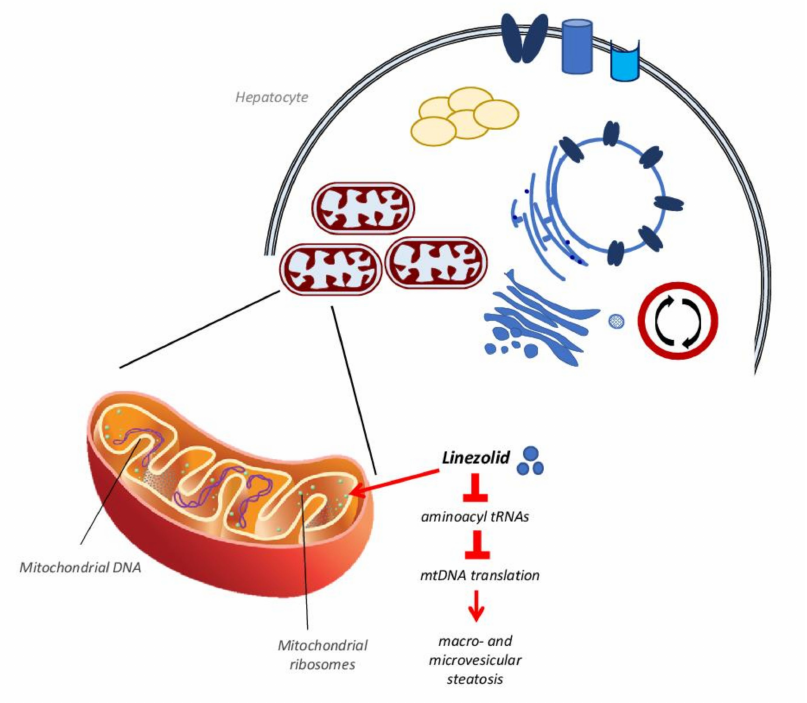
Figure 3. Linezolid activity on mitochondrial ribosomes. Linezolid stops the protein synthesis in bacteria by binding their ribosomes. At the same time, this drug can bind human mitochondrial ribosomes inhibiting the bond of aminoacyl tRNAs, blocking the mtDNA translation and reducing the mitochondrial respiration chain complexes activity. This process, after several weeks, produces micro and microvacuolar